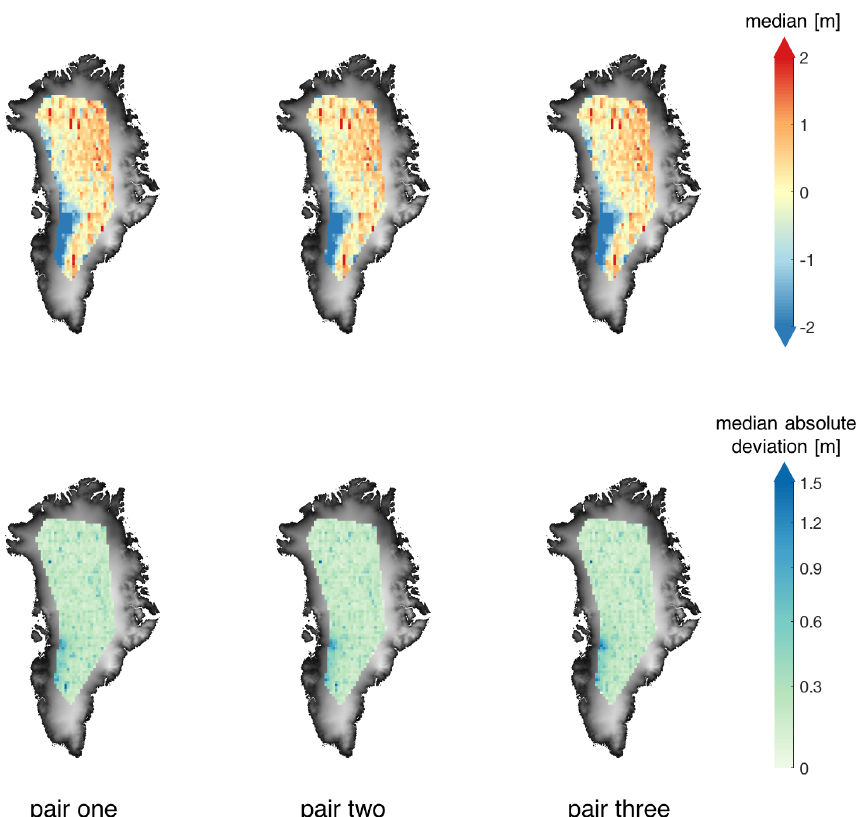
Figure A1. Spatial distribution of median and median absolute deviation of the height difference between each pair of ICESat-2 beams and ArcticDEM (tiled in 25km × 25km). The colours of the median absolute deviation plots are on a logarithmic